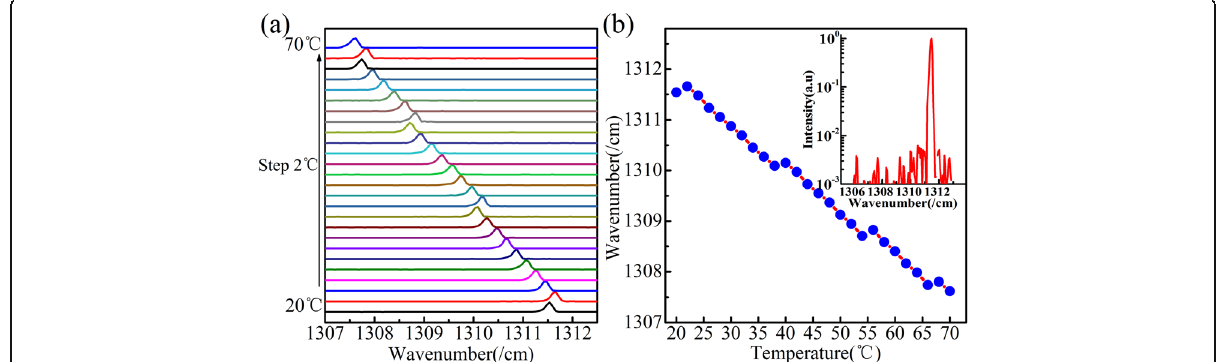
Fig. 2 a The emission spectra of laser changing with temperature. b The wavenumber versus temperature curve of the laser. The inset shows lasing spectrum of 24 °C by logarithmic